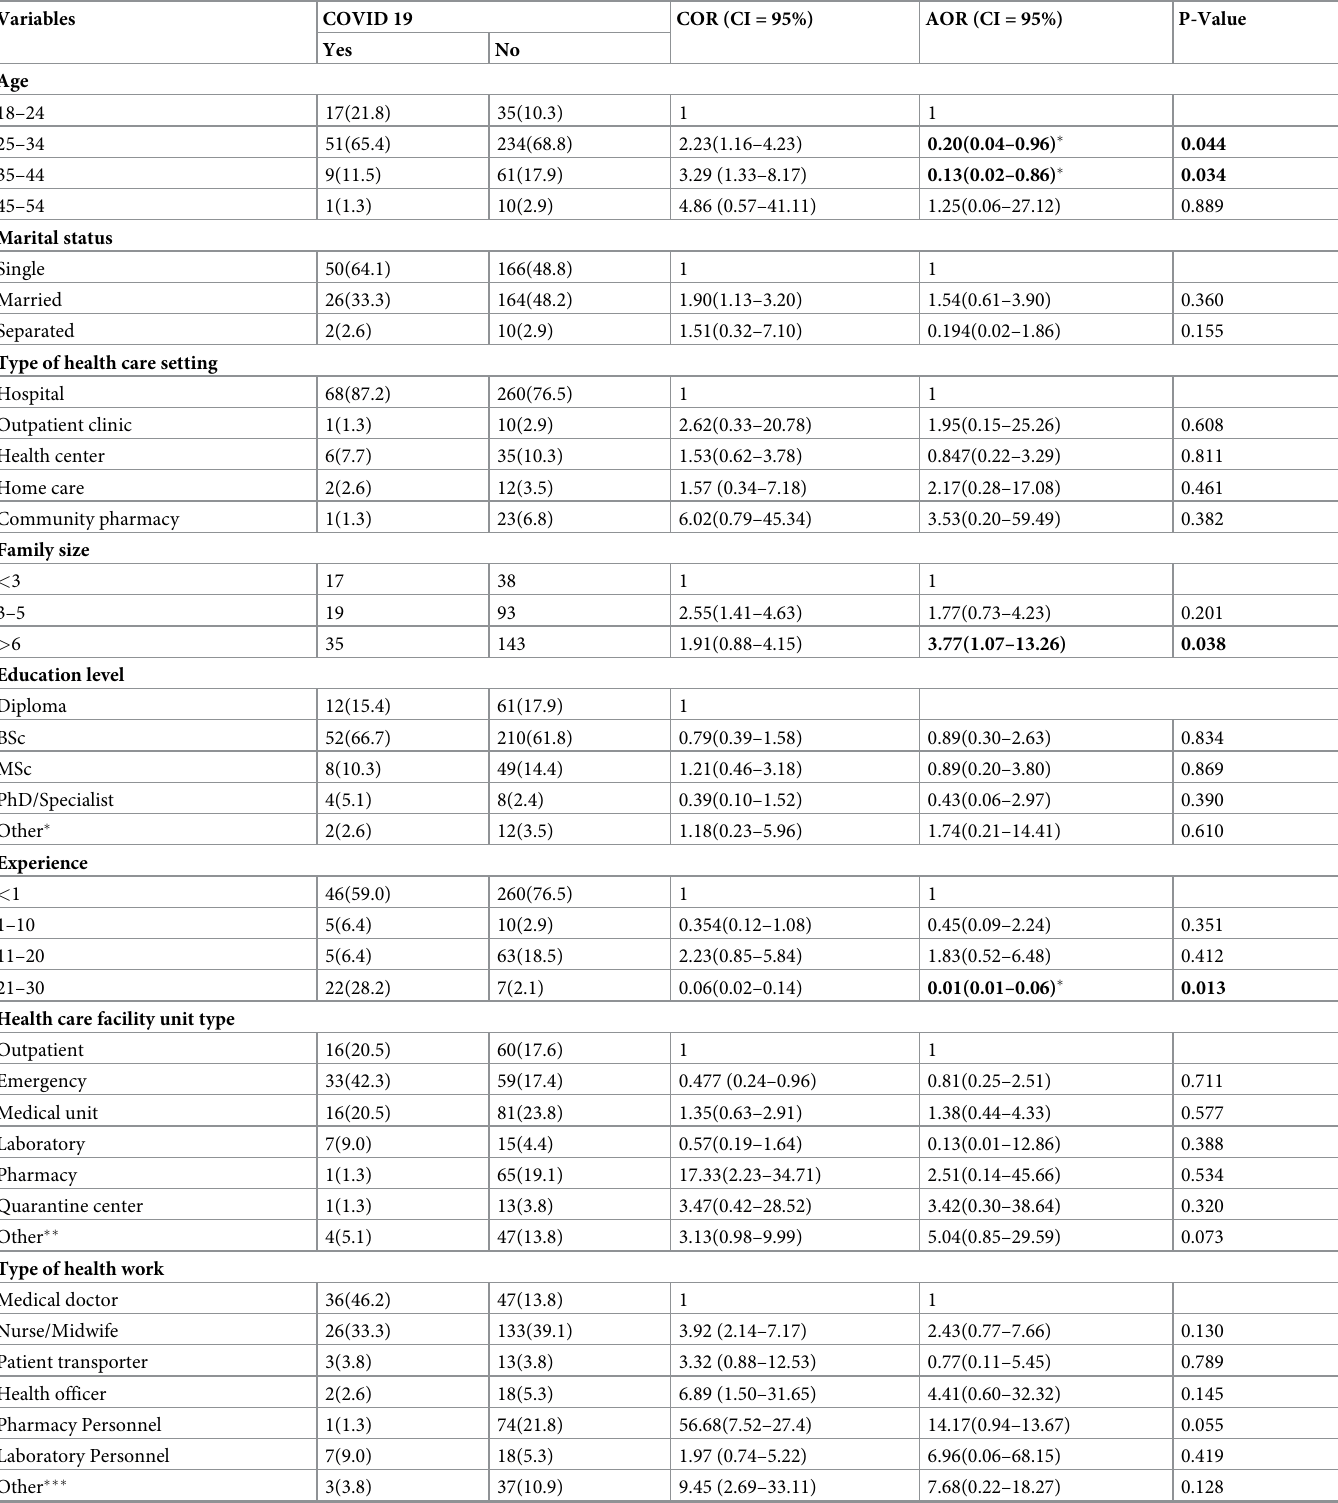
Table 5. Bivariate and multivariate logistic regression of confirmed COVID 19 cases and associated factors in the Amhara region, 2020 (N =